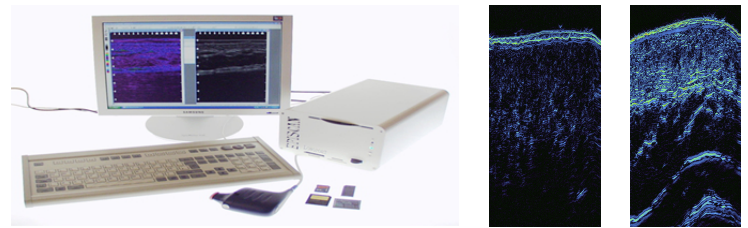
Figure 4. Episcan I-200 ultrasonic dermal scanner ( left ) and sample scans ( right ).